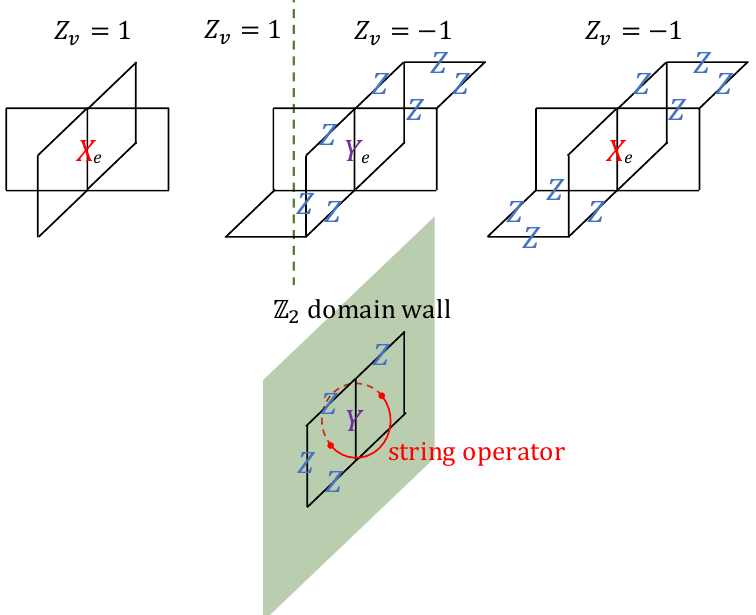
Figure 11: The intersection of the membrane and the domain wall is a fermion hop- ping